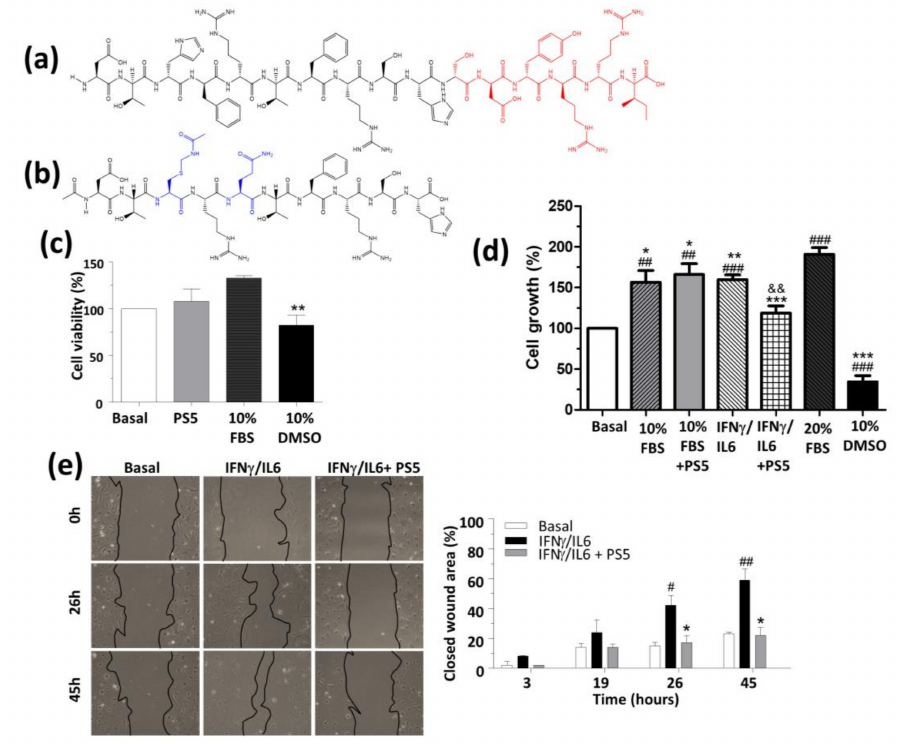
Figure 1. Structure and in vitro e ff ects of PS5 peptide on vascular smooth muscle cells (VSMCs). Chemical structure of ( a ) KIR SOCS1 and ( b ) PS5 peptide (red, residues deleted by Ala-scan analysis; blue, non-native